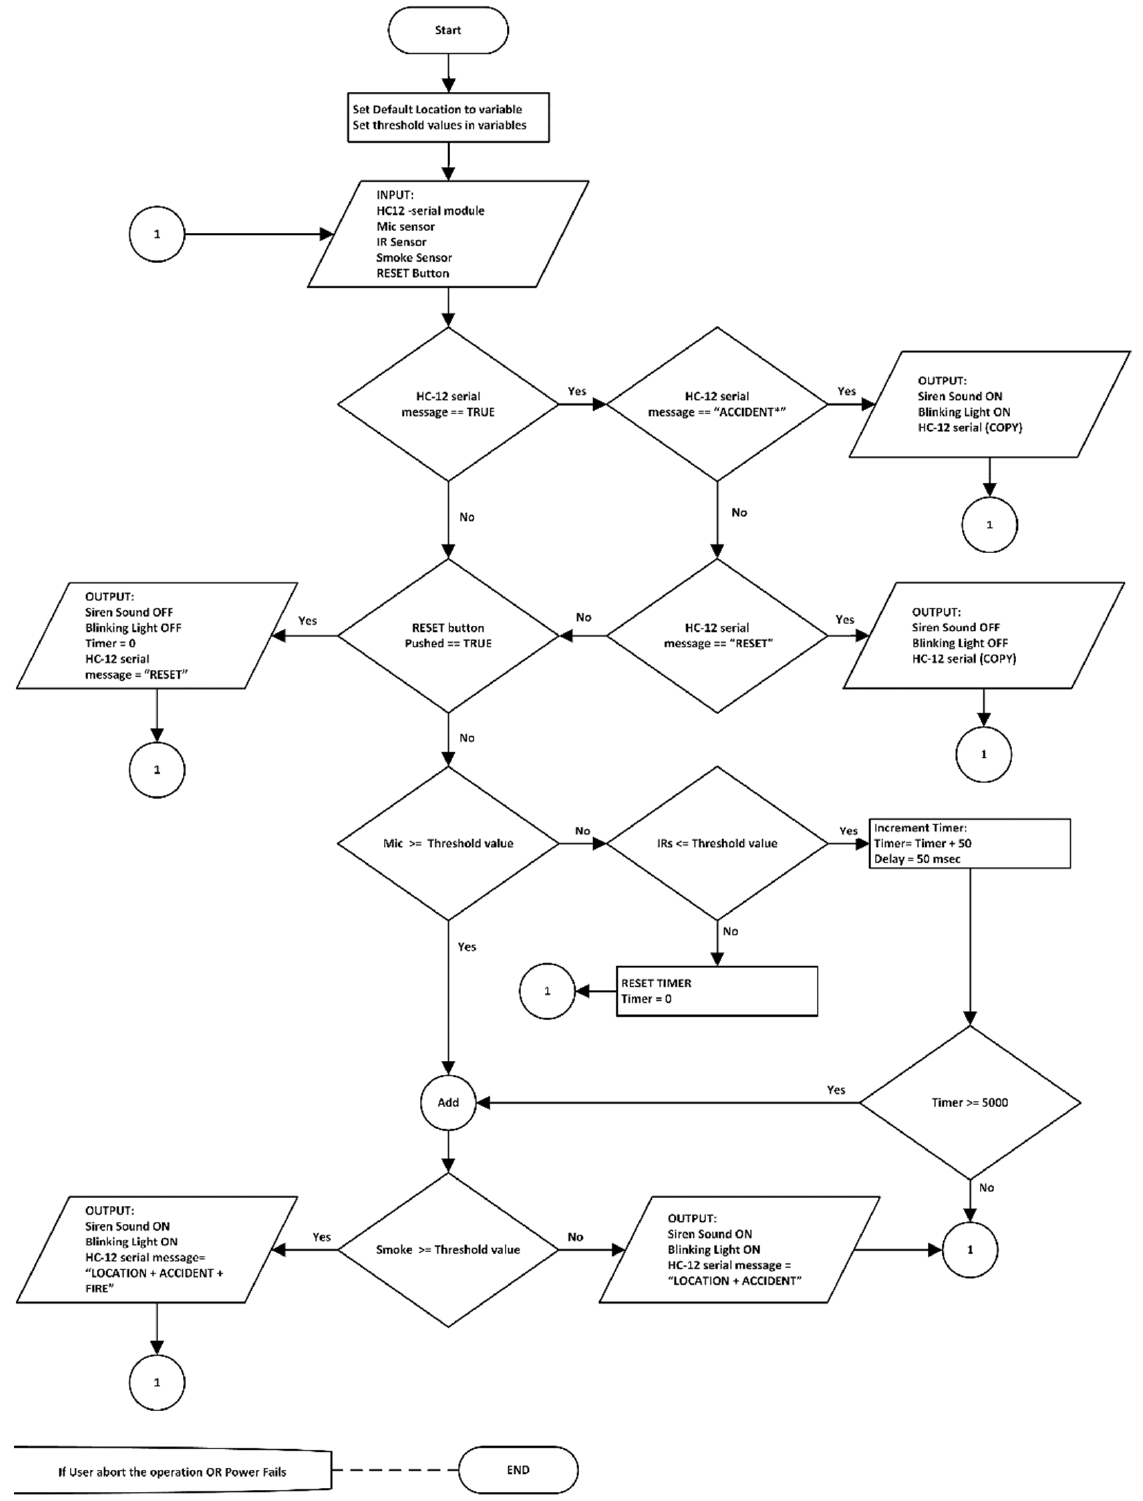
Figure 1. Proposed algorithm for an AALS node.